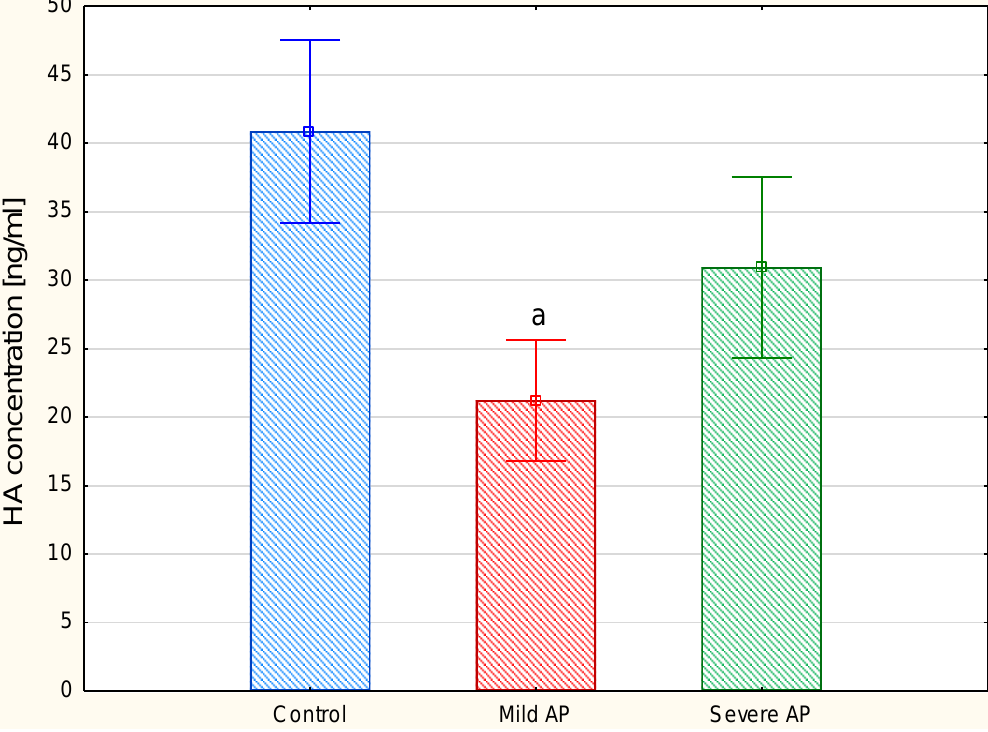
Figure 7. Concentrations of the circulating hyaluronan (HA) in the healthy controls and the patients with mild or severe acute pancreatitis (AP). HA was quantified in the plasma samples using ELISA-based test. Data are presented as means ± SD. a — differences statistically significant ( p = 0.001) compared to the healthy controls.